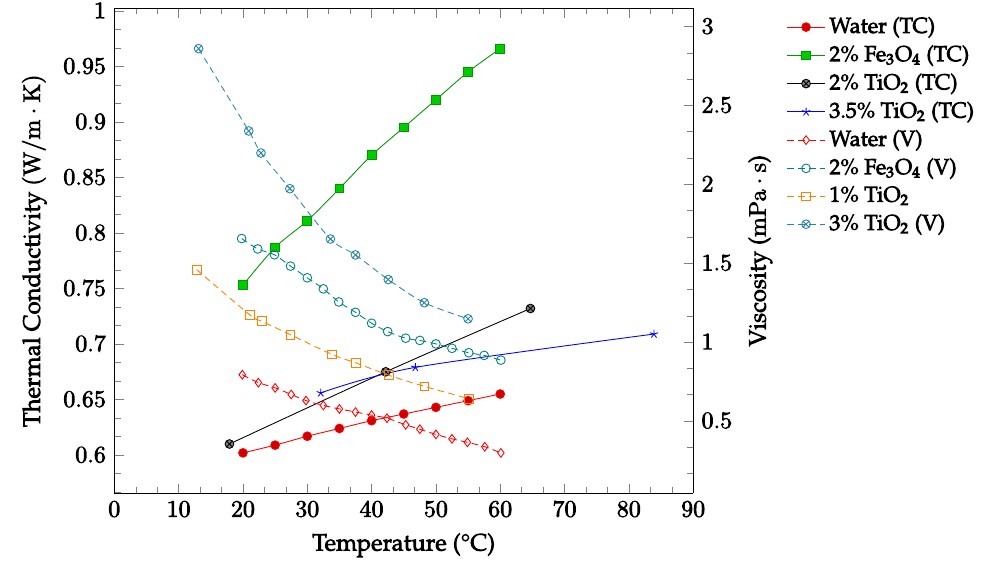
Figure 6. Nanofluid thermal conductivity and viscosity for volume fractions between 0–3.5% and temperatures between 10–90 °C for Fe 3 O 4 -water [15] and TiO 2 -water [46–48] nanofluids.